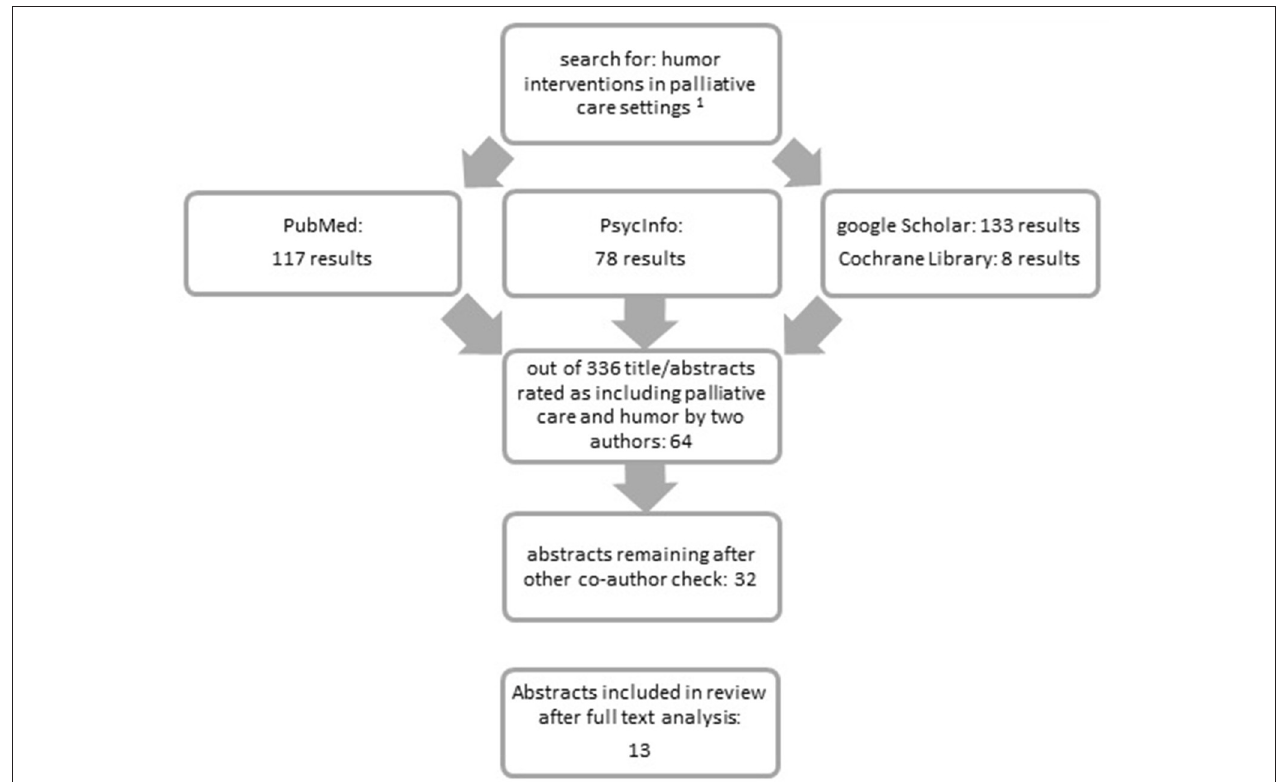
FIGURE 1 | Flowchart of the review protocol. 1 search terms: {(humor OR humor OR humorous OR clowns OR clown[Title/Abstract]) AND intervention OR training OR coaching OR visit OR practice OR therapy[Title/Abstract]} AND “palliative care” OR “hospice care” OR “end-of-life” OR geriatric OR “life limiting illness” OR death OR